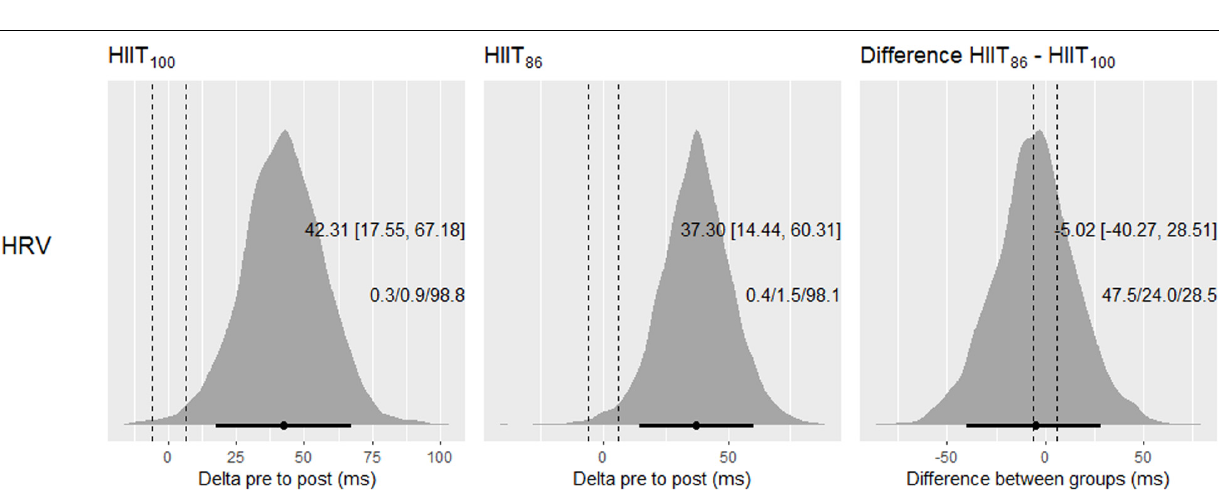
FIGURE 4 | Posterior density distributions and the respective means with 90% credible intervals of the pre to post changes in HRV in each HIIT model, and the comparison of changes between models. Black points and error bars are the posterior mean change and 90% credible intervals, respectively. Vertical dashed lines are the lower and upper boundaries of the ROPE (i.e., 0.2 × between subjects SD). The texts in each graph are the means (90% CI) and probabilities against